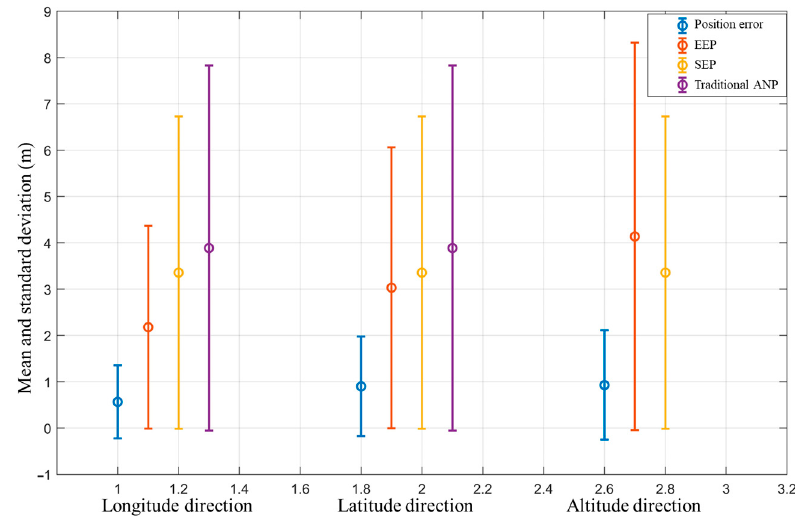
Figure 16. Statistical comparison chart of Monte Carlo simulation.